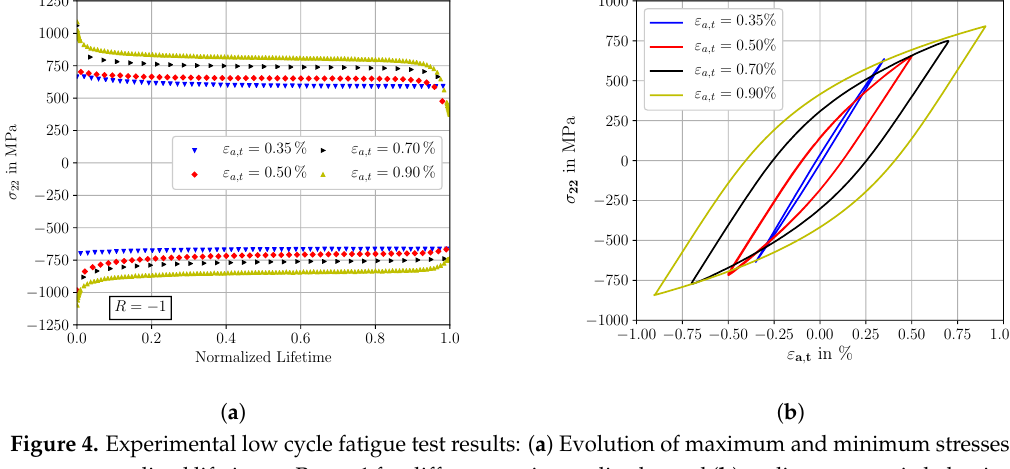
Figure 4. Experimental low cycle fatigue test results: ( a ) Evolution of maximum and minimum stresses versus normalized lifetime at R ε = 1 for different strain amplitudes and ( b ) cyclic stress-strain behavior − at R ε = 1, in cyclic stable material conditions (normalized lifetime = −